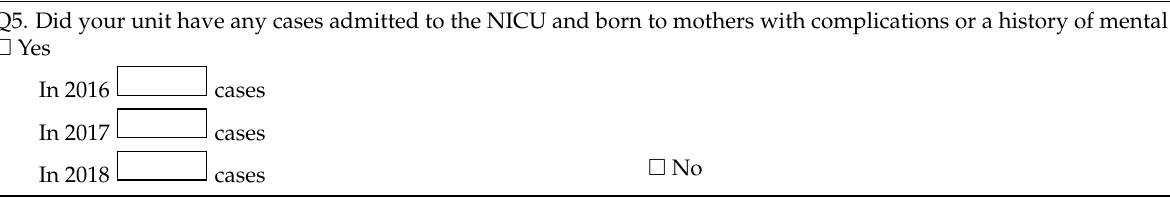
Table A1. Questionnaire for maternity care units.